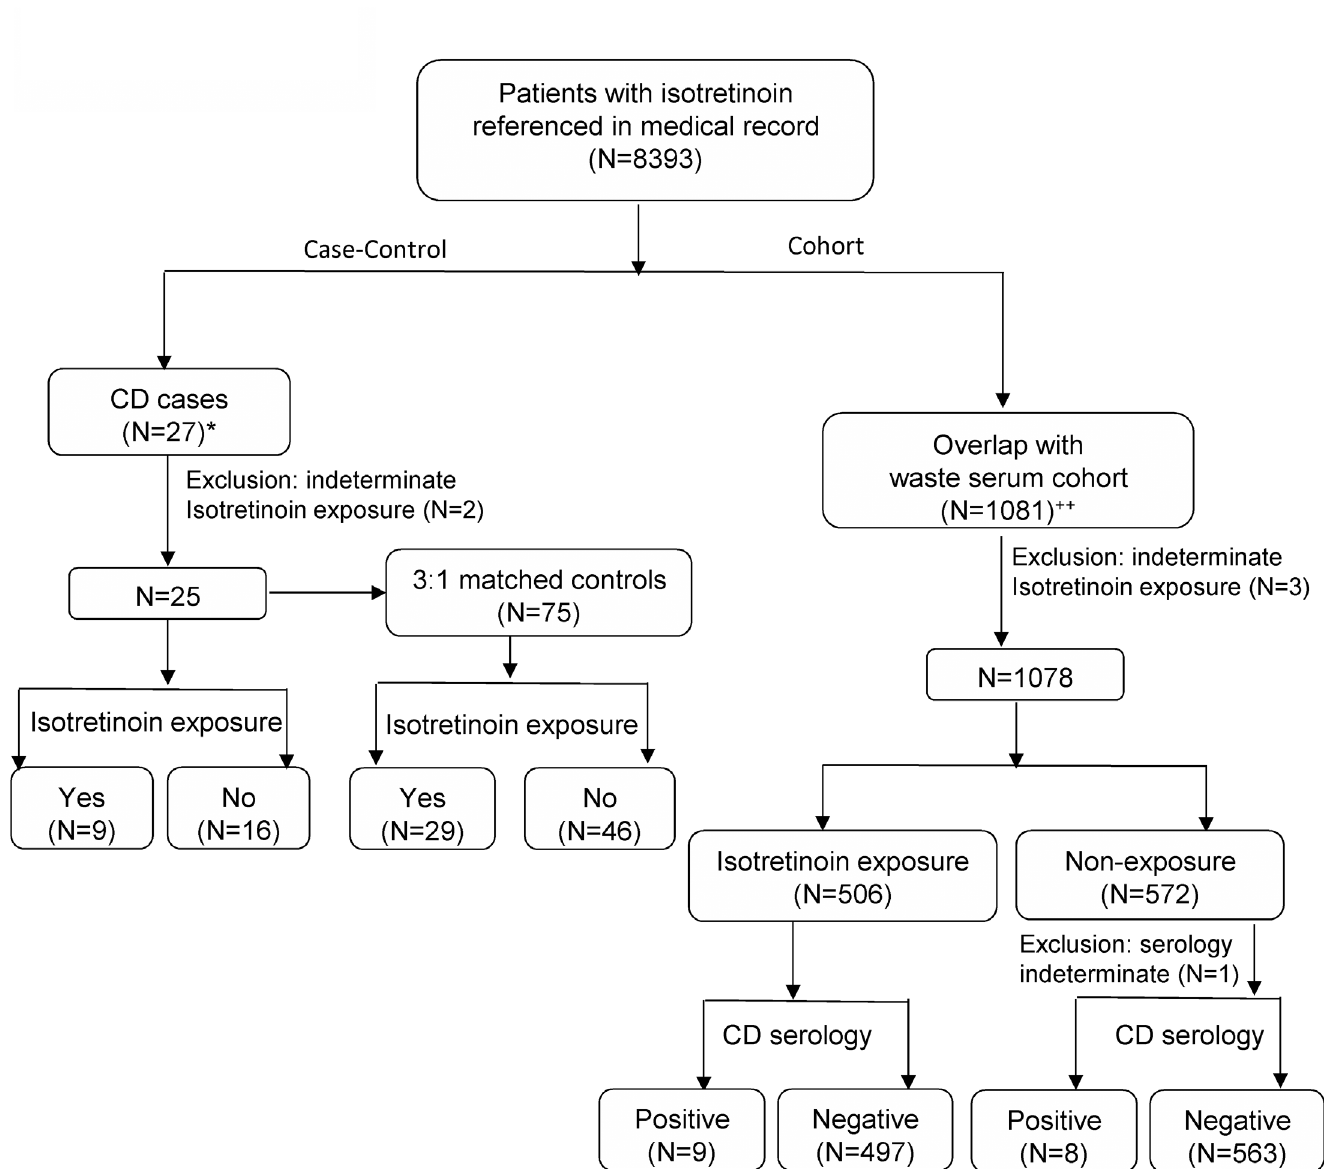
Fig 1. Flow diagram showing the number of patients who met the inclusion and exclusion criteria in each arm. In the left arm isotretinoin exposure was assessed among diagnosed CD patients and their age- and gender-matched controls (case-control design). In the right arm, latent CD (defined as positive CD serology) was assessed among patients with and without isotretinoin exposure (cohort